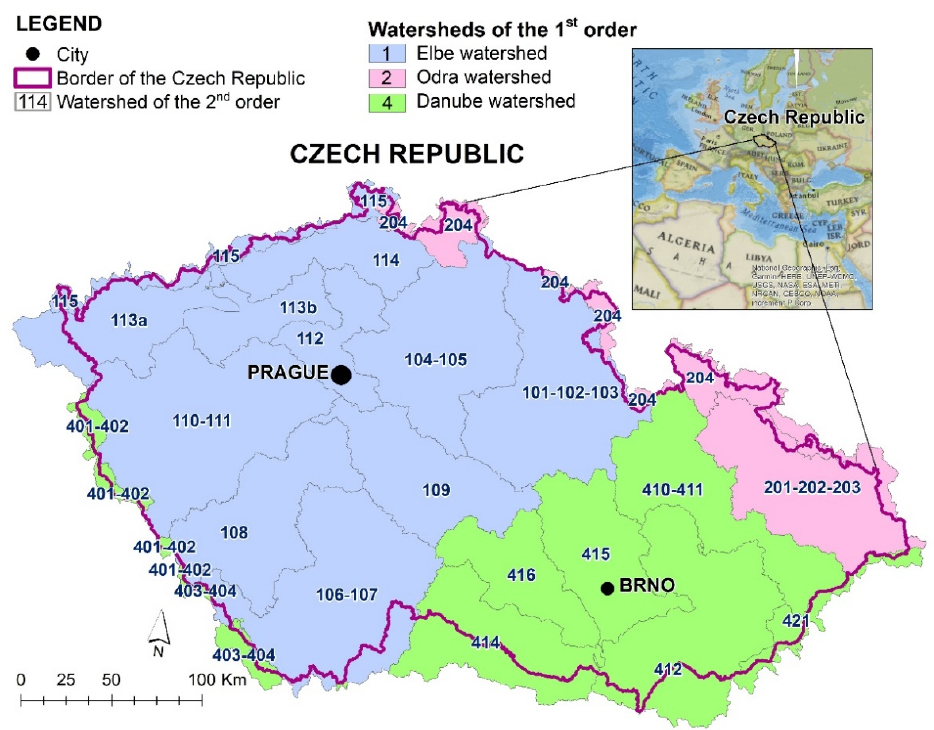
Figure 1. The study area and an overview of watersheds and groups of watersheds of the second